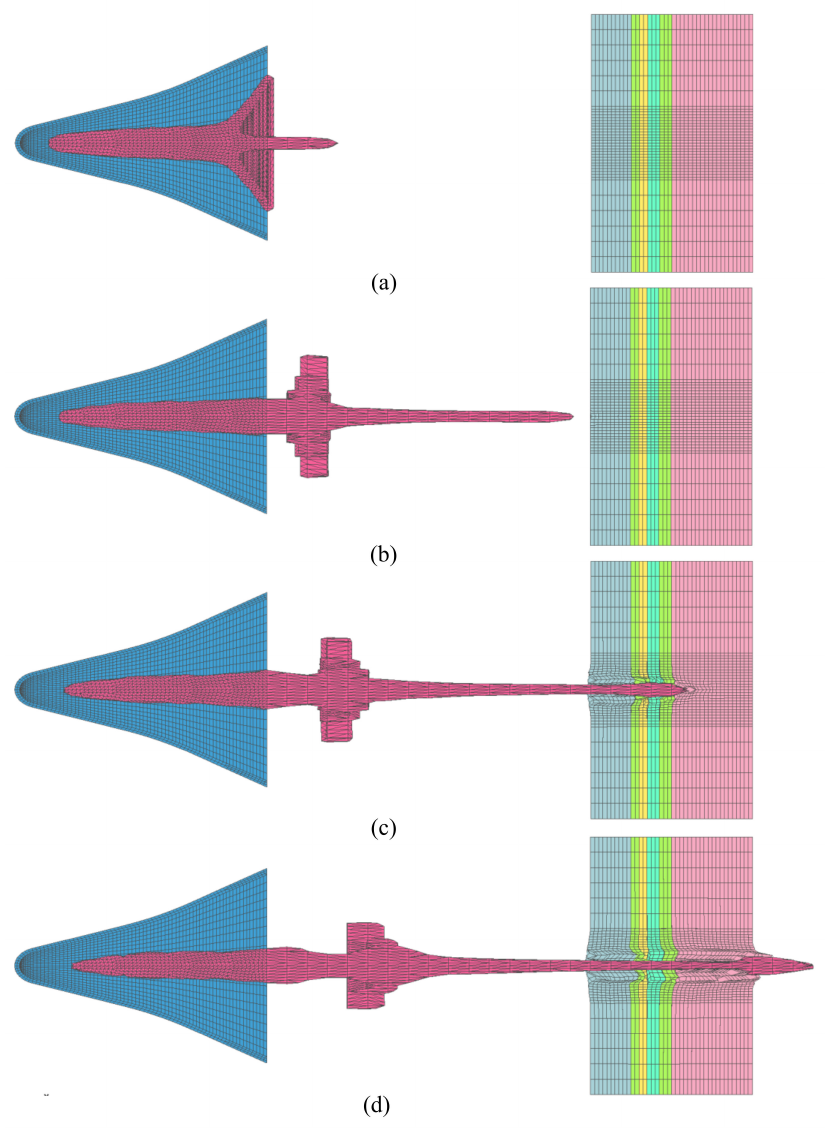
Figure 5. Penetration of the shaped charge jet into the simulated cabin target. ( a ) Jet condition when t = 20.5 µ s; ( b ) Jet condition when t = 28.5 µ s; ( c ) Jet condition when t = 33.5 µ s; and ( d ) Jet condition when t = 39.5 µ